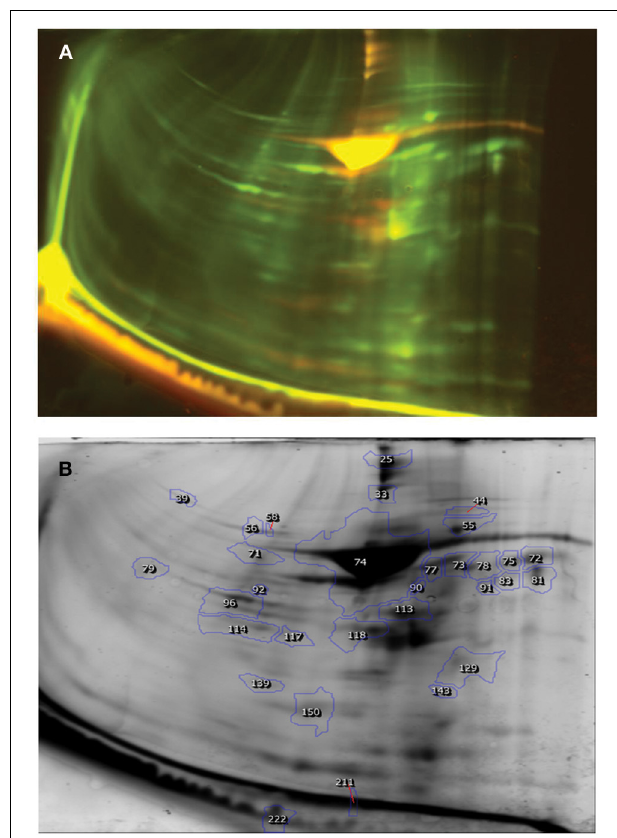
FIGURE 3 | DIGE image of Sertoli cell proteins (Holstein Friesian × Karan Fries). (A) DIGE image, (B) Differentially expressed spots.